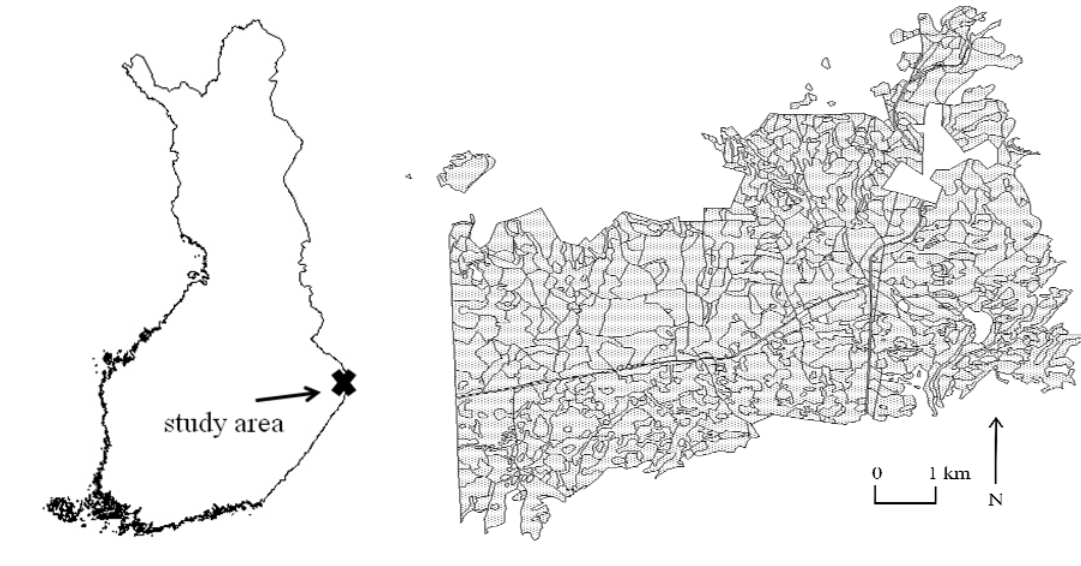
Figure 1. Location (left) and map with forest compartments (right) of the study area in Ilomantsi